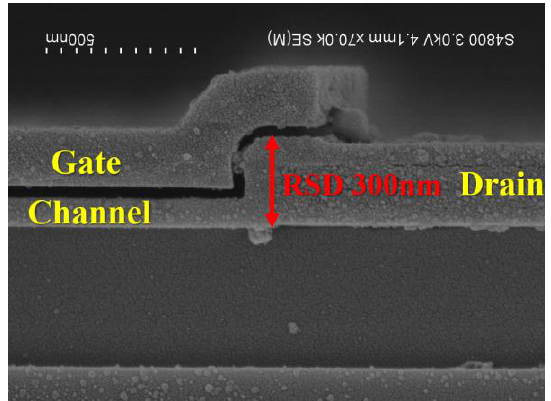
Figure 6. The SEM images of the Type C device with an RSD of 300 nm.